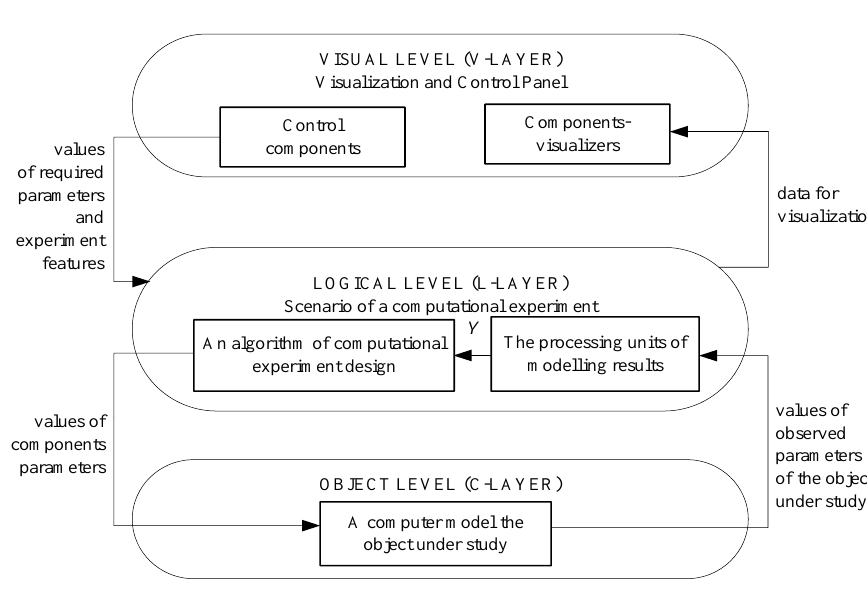
Fig. 2. Structure of a three-level computer model in simulation environment MARS For the purpose of a computational experiment, MARS SE includes:  a multi-layer diagram editor allowing the user to graphically design component circuit for the three